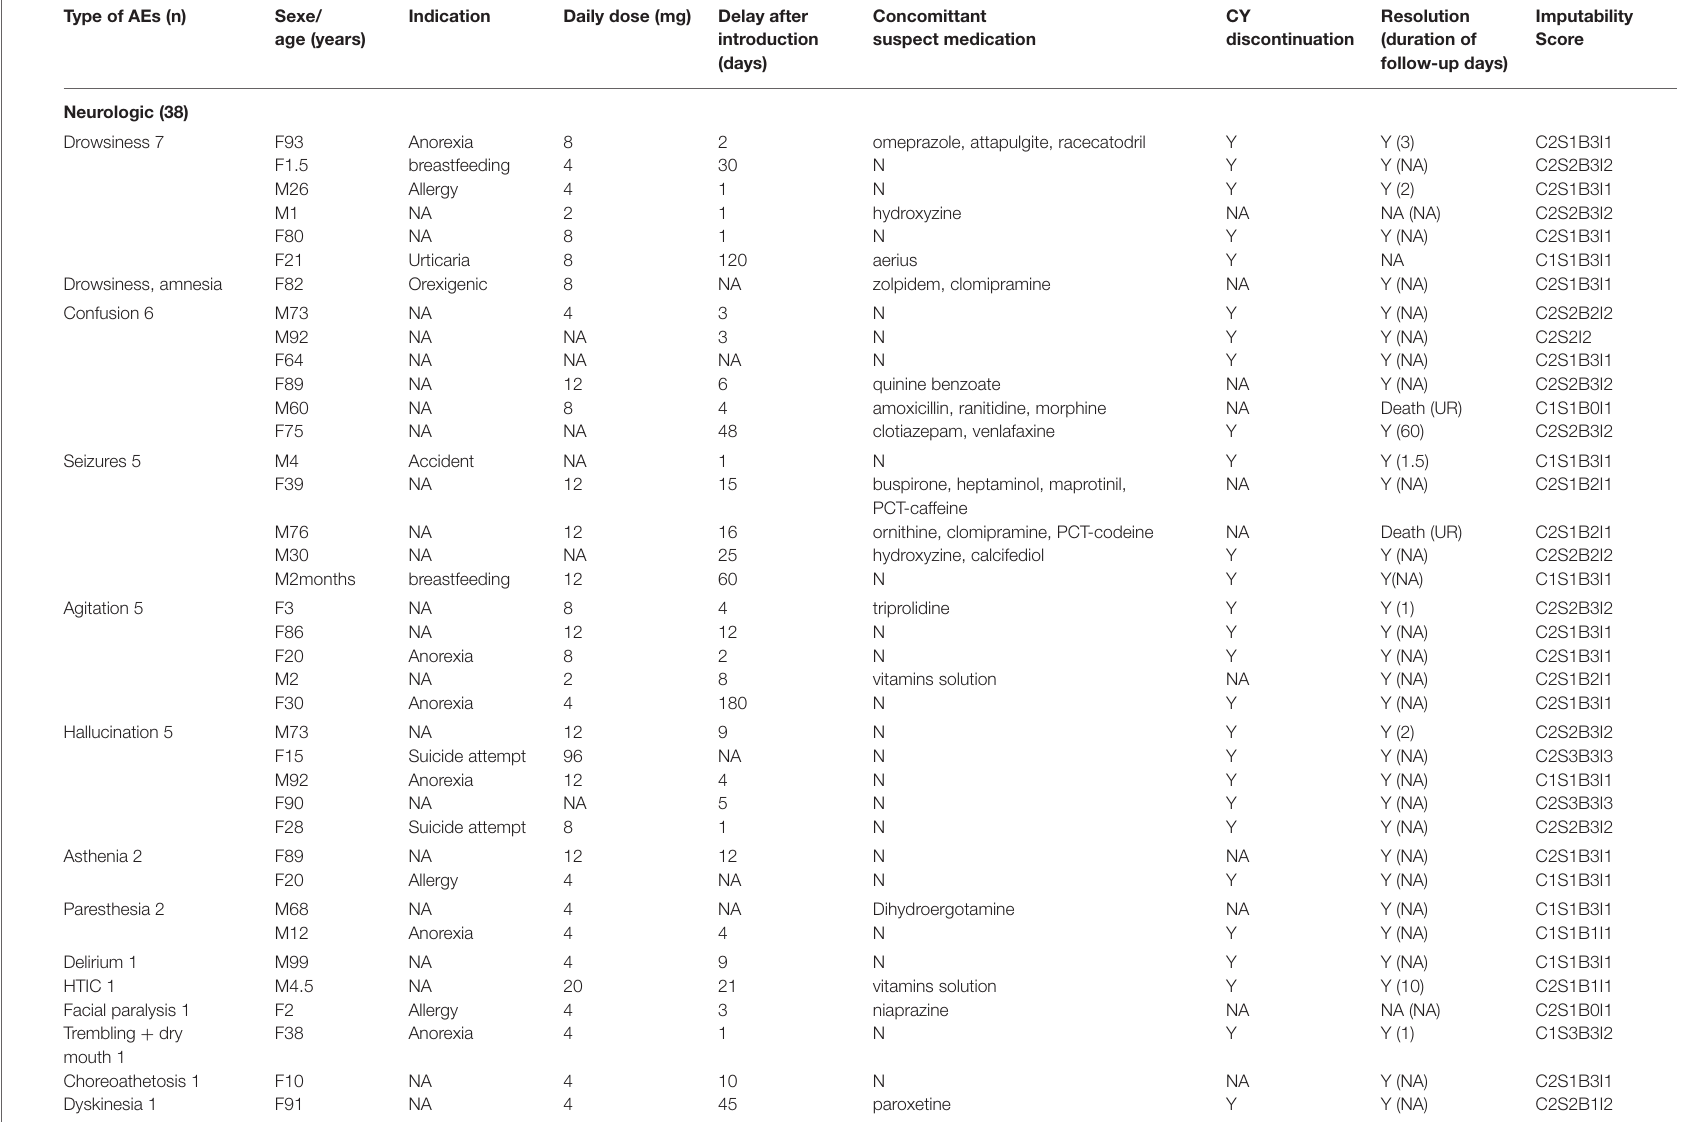
TABLE 2 | Cyproheptadine adverse effects (AEs) reported to the French national pharmacovigilance database between 1985 and December 31, 2020 ( n = 93). Type of AEs